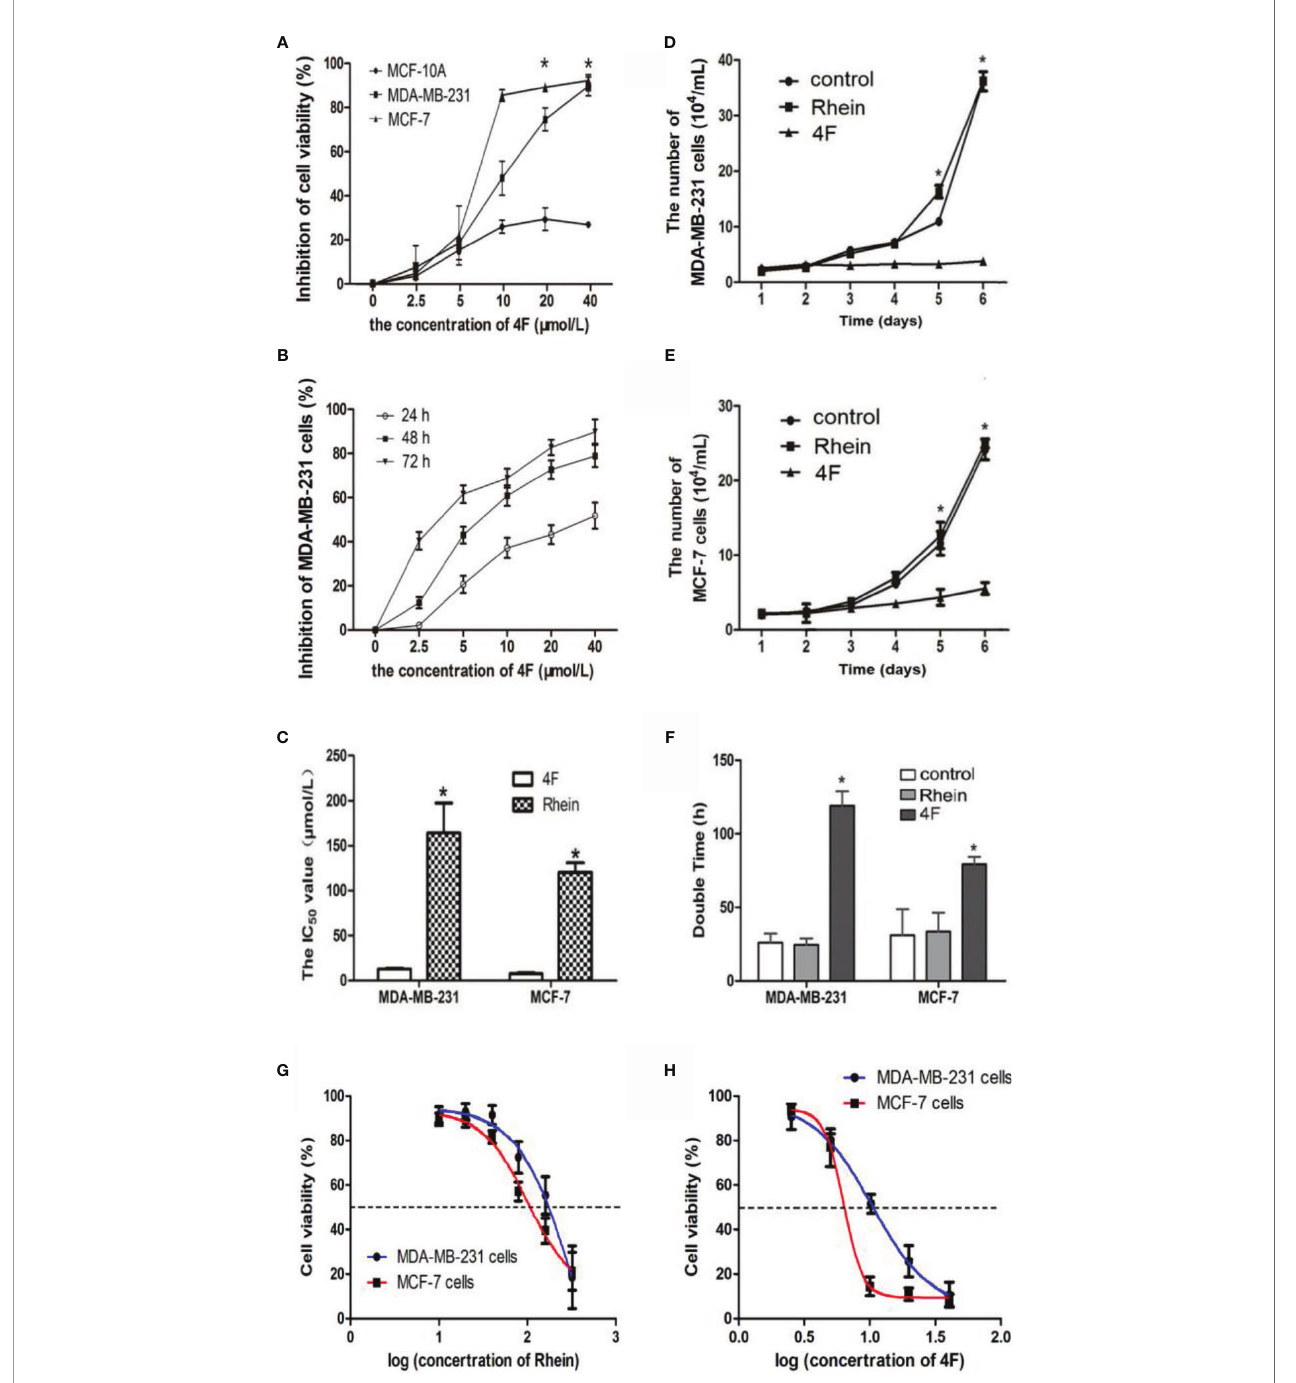
FIGURE 2 | Derivative 4F inhibition of breast cancer or normal cell proliferation. Control group corresponds to cells growing without any drug. Cell numbers were measured by cytometer. IC 50 values were calculated after 48 h of treatment. Data are shown as means ± SD (n = 3), one-way analysis of variance (ANOVA) was used for statistical analysis. (A) Comparison of derivative 4F cytotoxicity to breast cancer and normal breast cells. * P < 0.05, comparison of MCF-10A group and MDA-MB-231 or MCF-7 group. (B) MDA-MB-231 cells treated with different concentrations of derivative 4F for 24, 48, and 72 h. (C) IC 50 values of the two breast cancer cell lines. * P < 0.05, comparison of derivative 4F group and Rhein group. (D) Growth curve of MDA-MB-231 cells. * P < 0.05, comparison of derivative 4F group and control group. (E) Growth curve of MCF-7 cells. * P < 0.05, comparison of derivative 4F group and control group. (F) Doubling time of two breast cancer cell lines. * P < 0.05, comparison of derivative 4F group and control group. (G) IC 50 curve of Rhein in MDA-MB-231 and MCF-7 cells. (H) IC 50 curve of derivative 4F in MDA-MB-231 and MCF-7